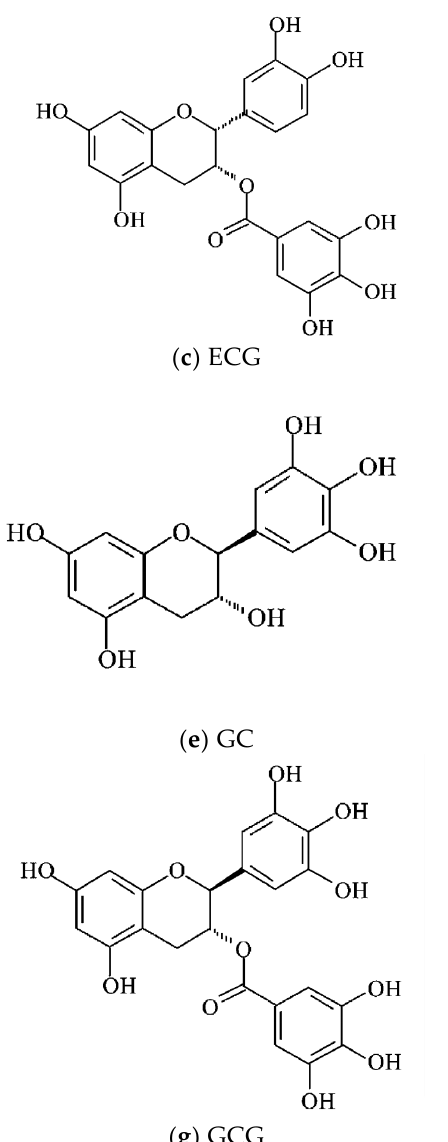
Figure 2. The chemical structures of major kinds of catechins. ( a ) catechin: (2 R ,3 S )-(+)-catechin; (2 R ,3 S )-2-(3,4-dihydroxyphenyl)-3,4-dihydro-2 H -chromene-3,5,7-triol; ( b ) EC: (2 R ,3 S